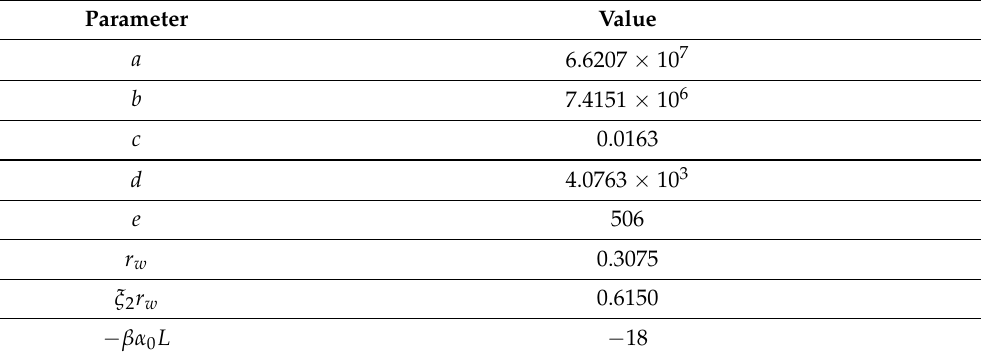
Table 1. Parameters of the normalized system of equations for the EDFL, Equation